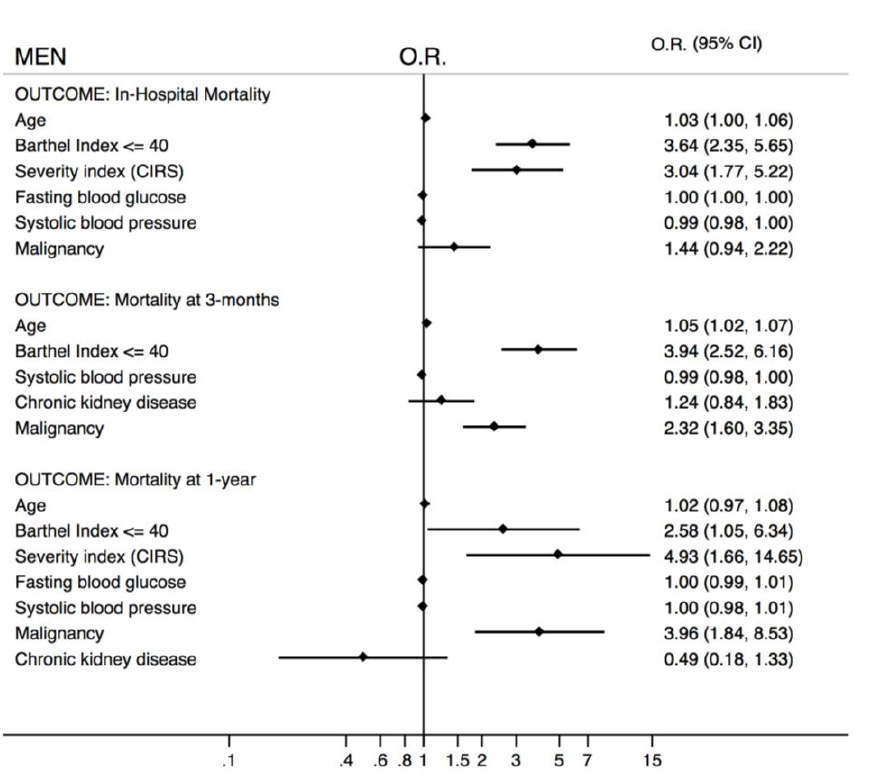
Figure 5. Multivariate analysis according to in-hospital, 3-month, and 1-year mortalities in the male population (OR = odds ratio; 95% CI = 95% confidence interval).